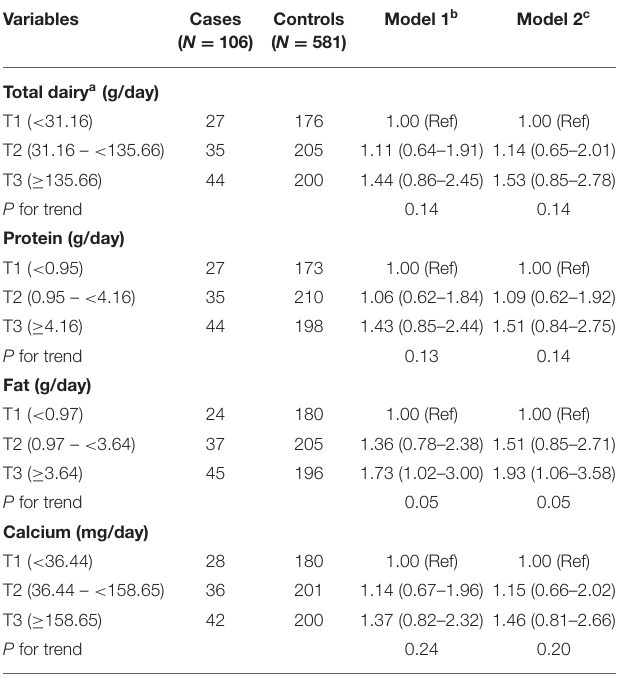
TABLE 2 | Adjusted ORs and 95% CIs for oligo-astheno-teratozoospermia by intake of dairy products and their related nutrients. Variables